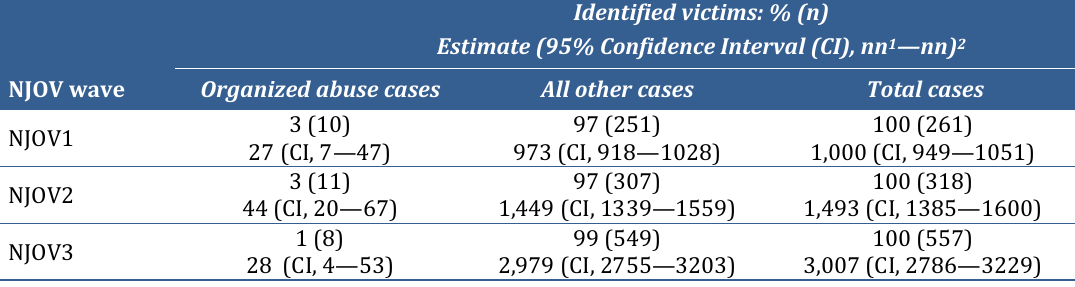
Table 2: Prevalence of technology ‐ facilitated organized abuse arrest cases; estimated number of cases in the 3 waves of National Juvenile Online Victimization (NJOV) Study